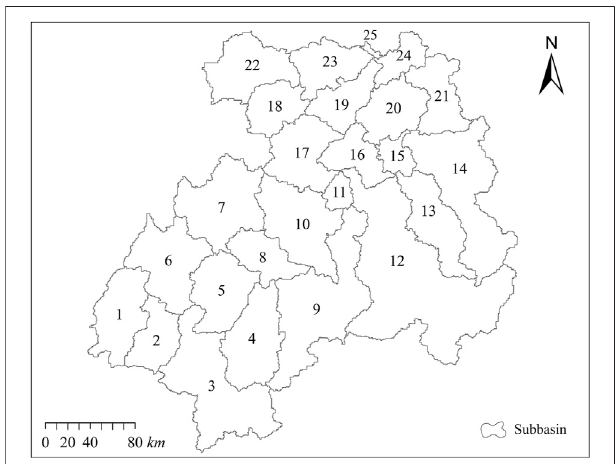
FIGURE 3 | Spatial division of modeled units (subbasins) in the Xiangjiang River